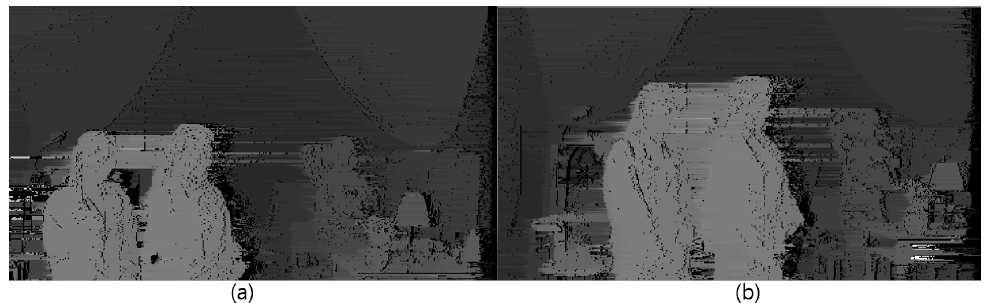
Figure 7. Two images with different scaling factors can be appropriately depth mapped from each perspective if the scaling factor is accurately estimated. ( a , b ) are the depth maps of the images of Figure 6a,b,